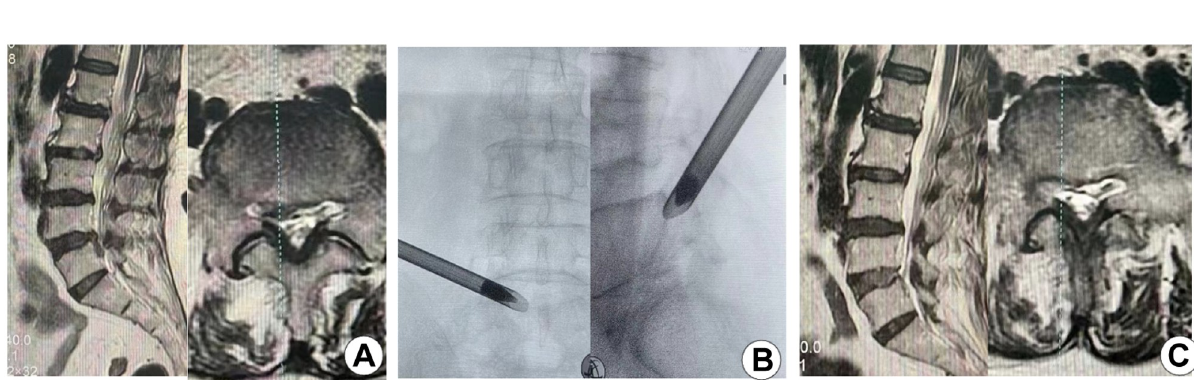
Fig 4. Typical case two. (A) Preoperative MRI showed the disc prolapse at the L4-L5 level. (B) Intraoperative anteroposterior and lateral fluoroscopy on the working cannula. (C) Postoperative MRI showed the complete removal of the protruded nucleus pulposus.